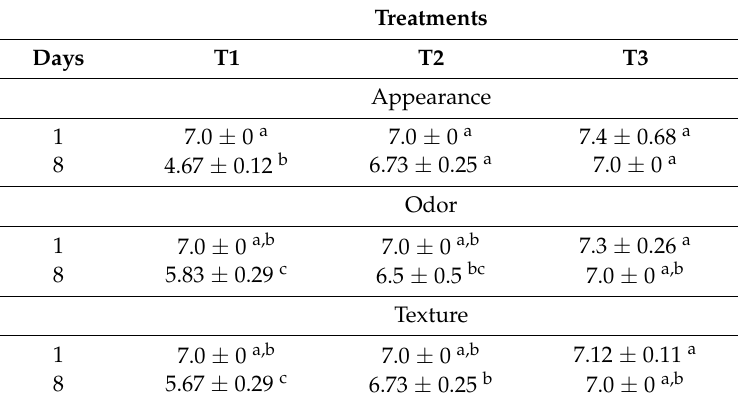
Table 4. The effect of surimi-based coating on sensory scores of shrimp during storage at 4 ± 1 ◦ C.